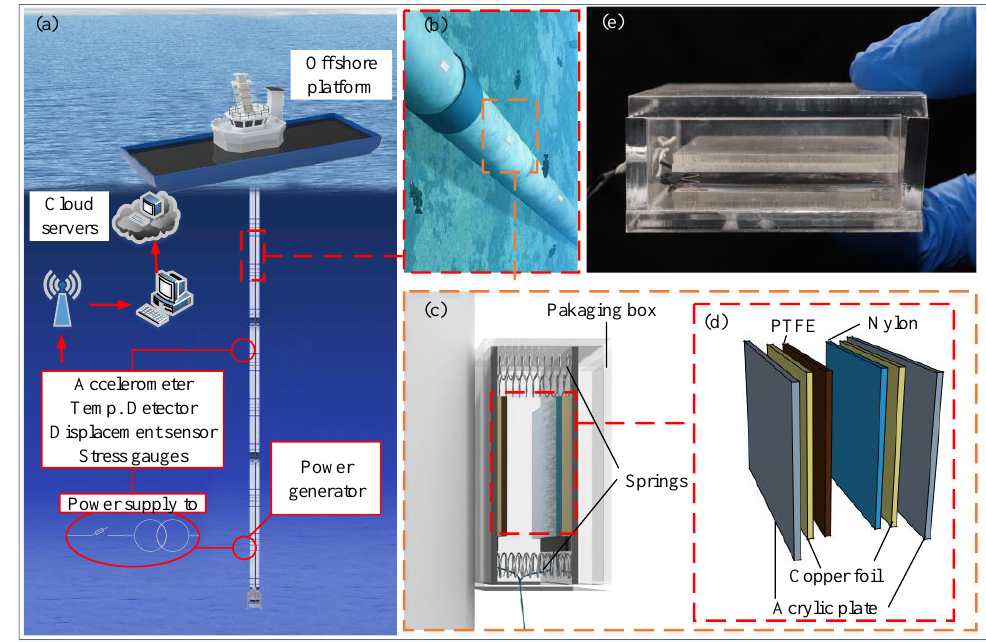
Figure 1. A sketch of the developed TENG devices in application of ocean pipe vibration energy harvesting. ( a , b ) are the perspective of the device arrangement at pipe; ( c , d ) are illustration of the energy harvesting system and detailed structural diagram of the tribo-pair of TENG device; ( e ) is the fabrication of the TENG device sealed by a waterproof box.